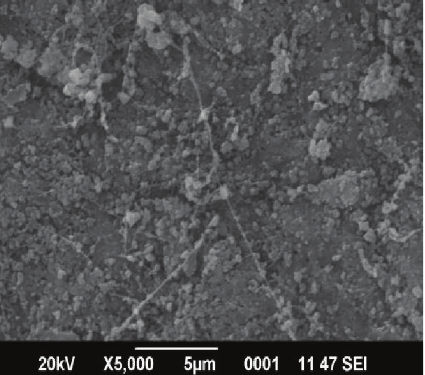
Figure 4: SEM image of cellulose produced by Gluconacetobacter